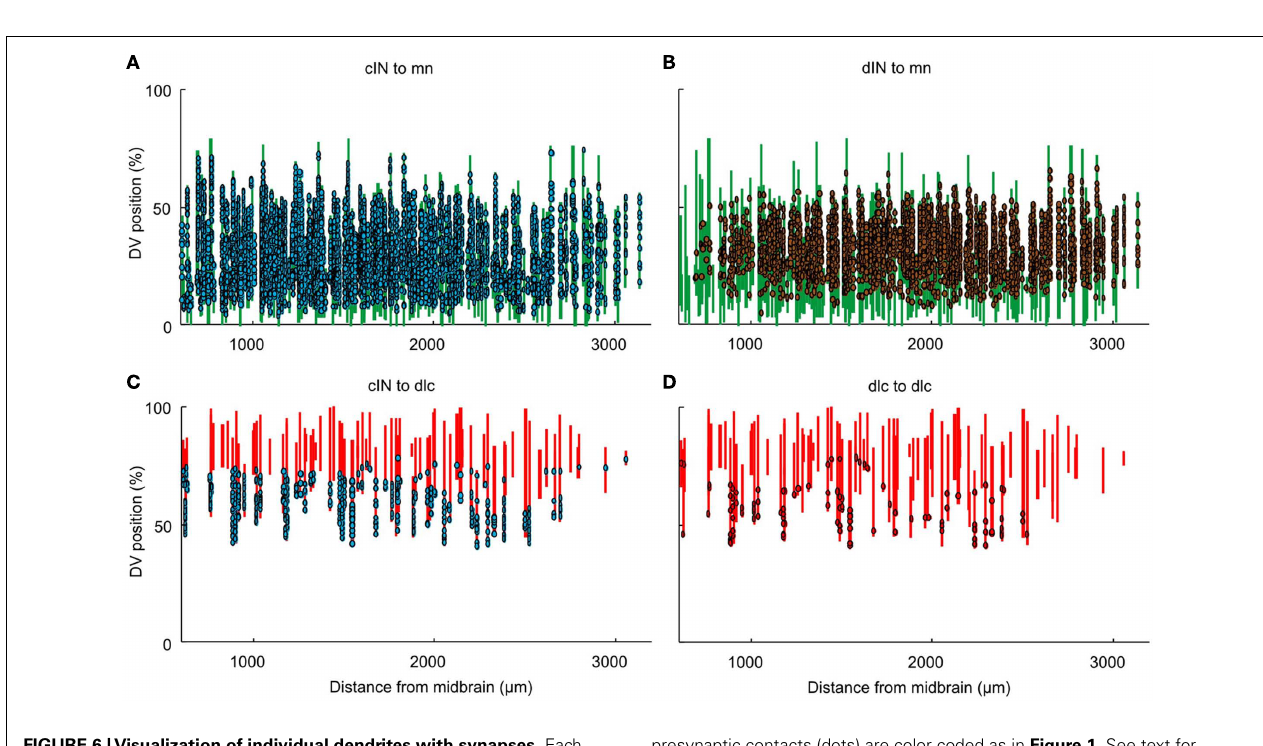
presynaptic contacts (dots) are color coded as in Figure 1 . See text for details. (A) from cIN to mn. (B) from dIN to mn. (C) from cIN to dlc. (D) from dlc to